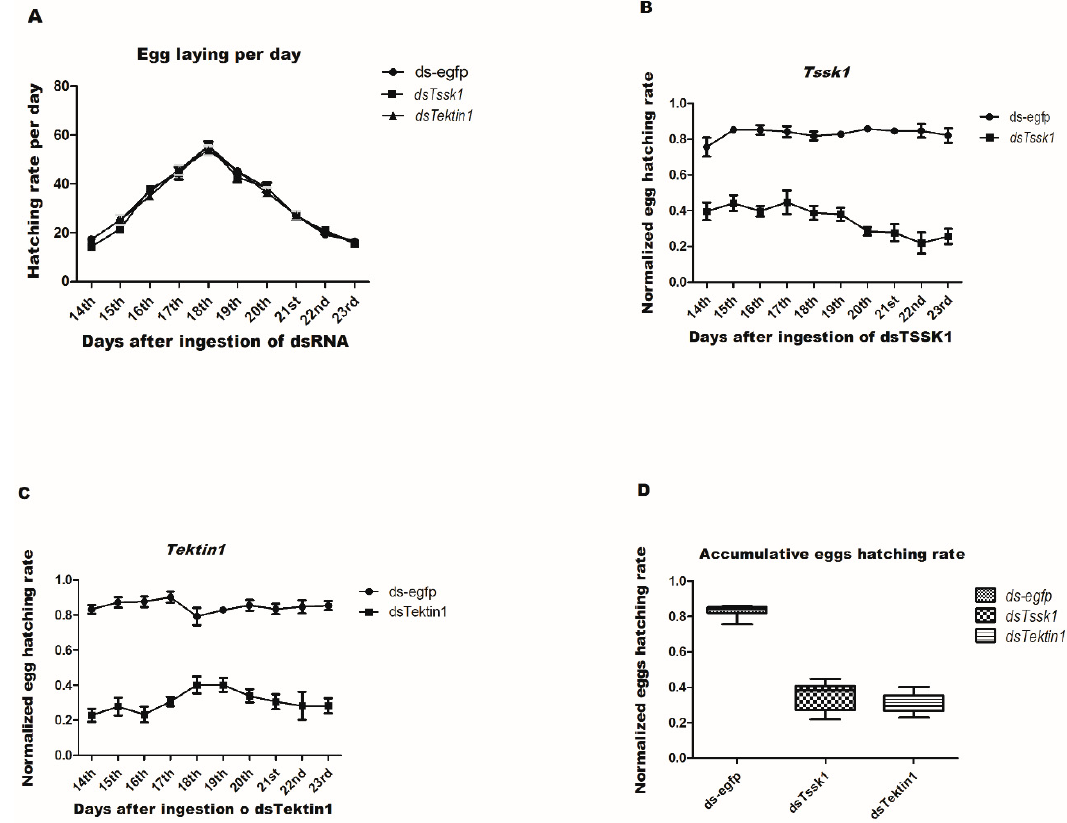
Figure 6. Reduced expression of Tssk1 and Tektin1 in testis have decreased the male fertility in B. dorsalis .